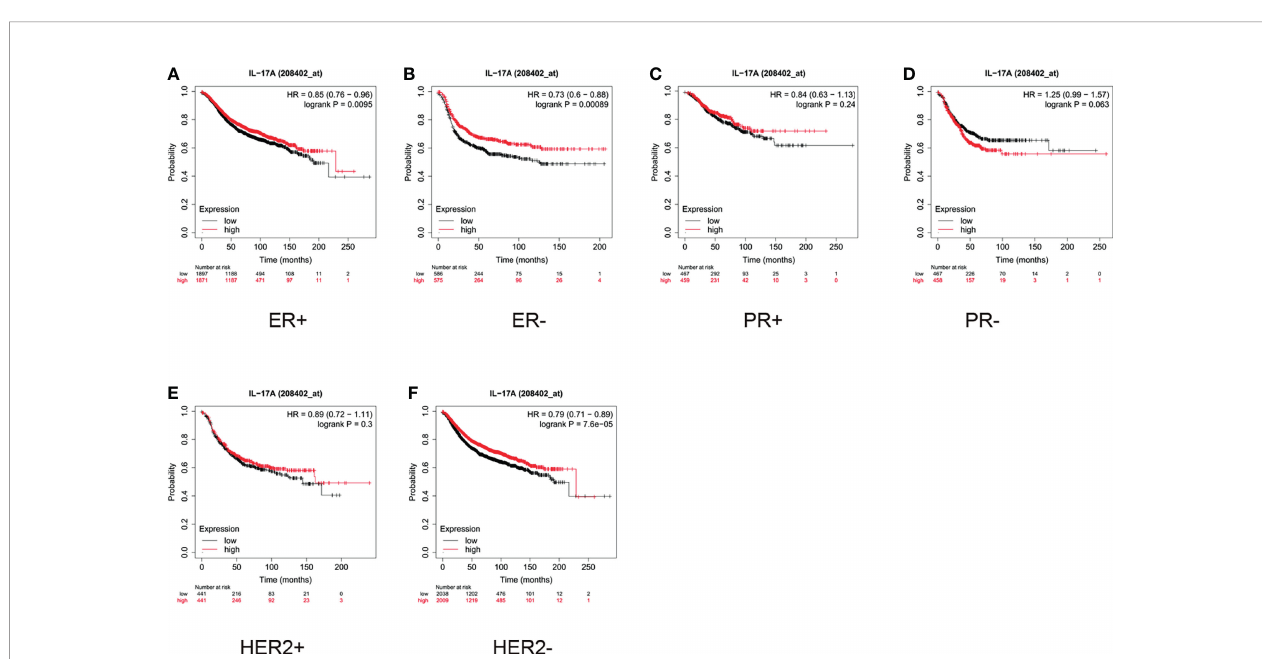
FIGURE 4 | In patients with breast cancer, high interleukin (IL)-2 expression only indicated better prognosis in estrogen receptor-negative (ER-) and human epidermal growth factor receptor 2 negative (HER2-) subgroups. (A) High expression of IL-2 (A) did not correlate with better prognosis in ER+ patients (hazard ratio [HR] = 0.94, p = 0.29) and (B) indicated better prognosis in ER- patients (HR = 0.79, p = 0.015). (C, D) . IL-2 expression did not signi fi cantly in fl uence survival in progesterone receptor-positive (PR+; HR = 0.99, p = 0.96) or PR- (HR = 1.11, p = 0.36) subgroups. High expression of IL-2 (E) did not correlate with better prognosis in HER2+ patients (HR = 0.89, p = 0.3) and (F) indicated better prognosis in HER2- patients (HR = 0.86, p =